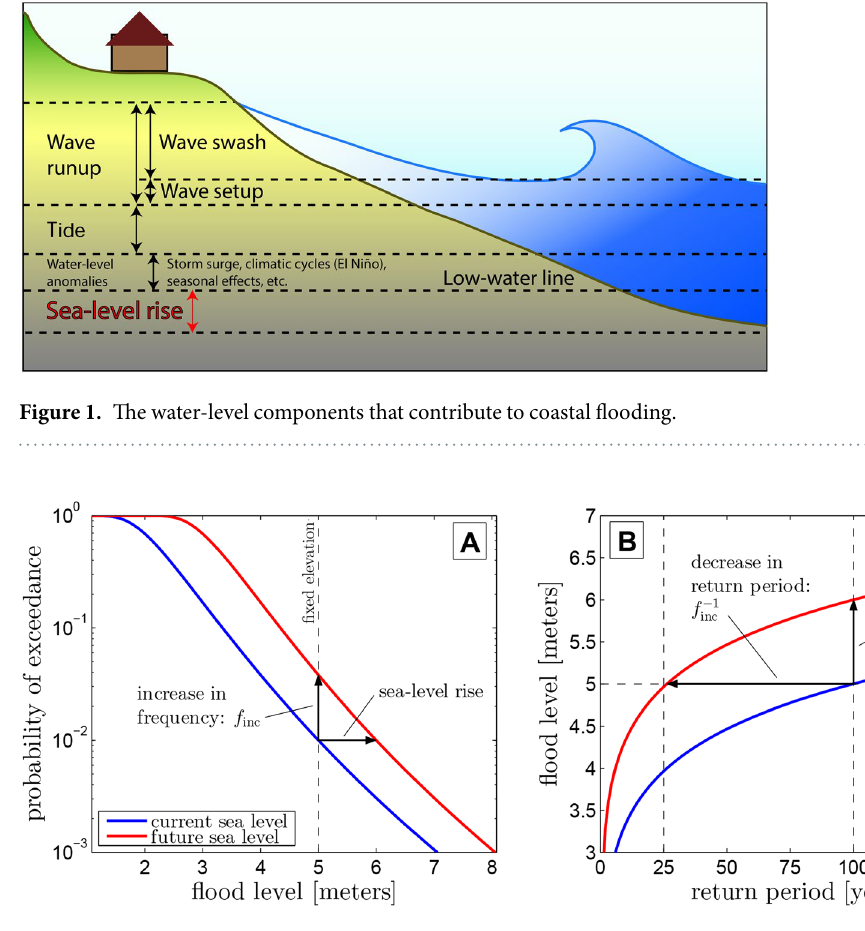
Figure 2. Example: by elevating the exceedance probability distribution, a 1 m increase in SL increases the frequency ( A ) and lowers the return period ( B ) of the 5m-flood level. Note that the steeper the probability distribution in A, the flatter the return time curve in B, i.e., the greater the increase in frequency and the reduction in return time. Thus regions with lower variability in flood level will experience larger increases in flooding frequency under SLR. See Methods and extended data Figs 1 and